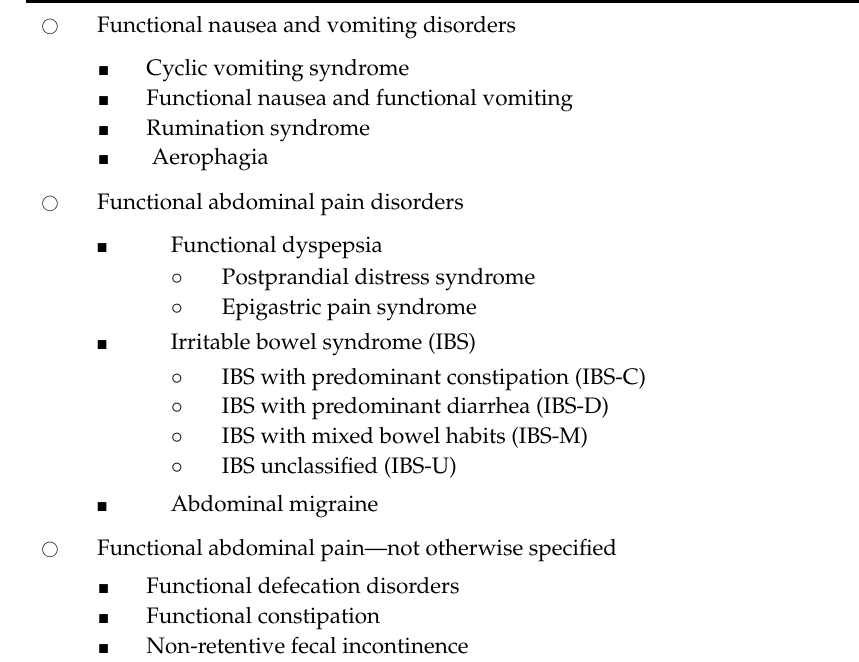
Table 1. Rome IV classification for functional gastrointestinal disorders for children and adolescents